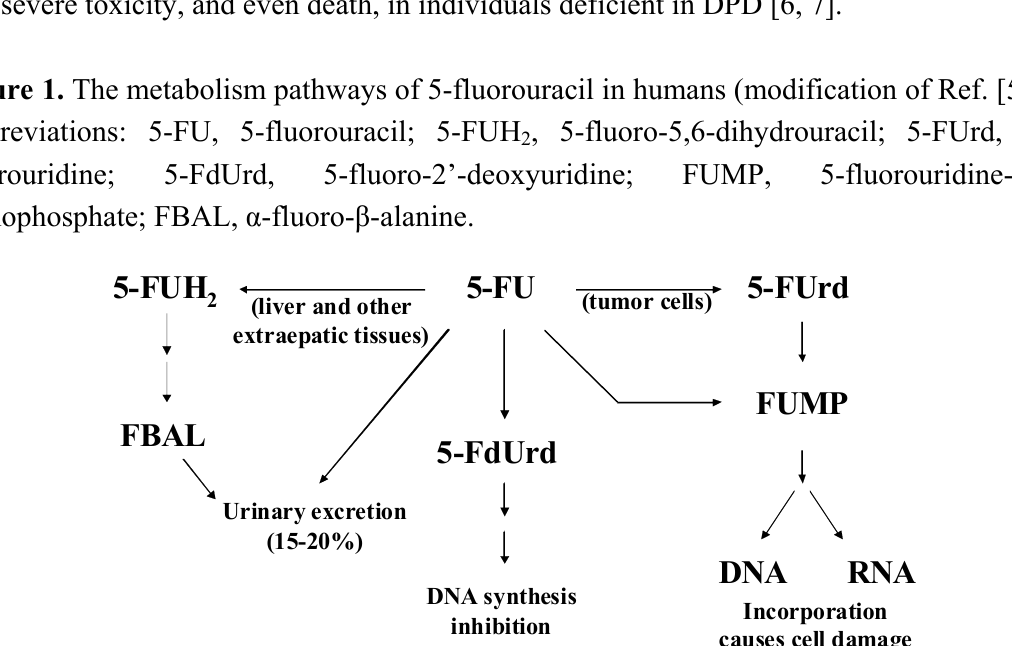
Figure 1. The metabolism pathways of 5-fluorouracil in humans (modification of Ref. [5]). Abbreviations: 5-FU, 5-fluorouracil; 5-FUH